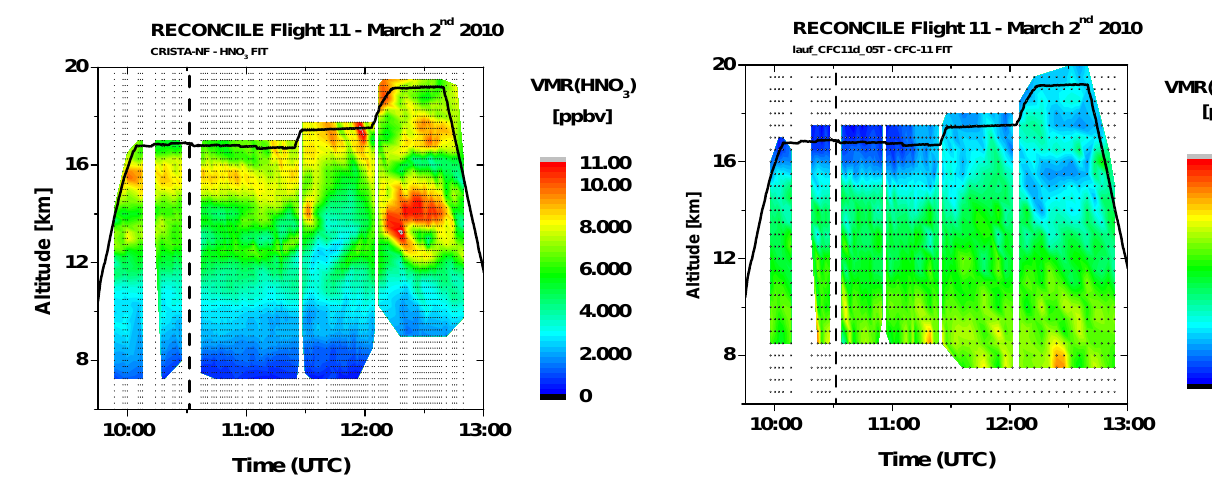
Fig. 19. Vertical cross-section of HNO 3 along flight track derived from CRISTA–NF measurements (compare Fig. 18).